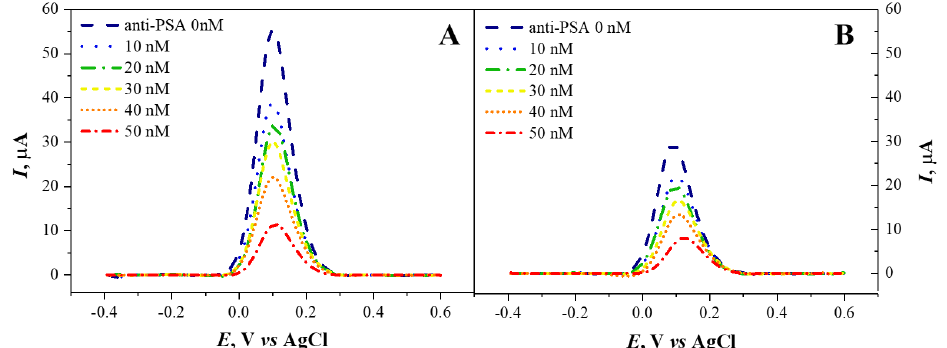
Figure 7. Differential pulse voltammograms of SPCE/ZnO-Nafion No. 2/PSA ( A ) and SPCE/ZnO- Nafion No. 3/PSA (after BSA blocking) ( B ) registered after interaction with different concentrations of anti-PSA. Potential range from −0.4 to +0.6 V with step size of 4 mV, pulse height of 0.05 V, pulse period of 100 ms, pulse width of 50 ms in 0.01 mM PBS, pH 7.4, containing 2.5 mM [Fe(CN 6 )] 3−/4− .